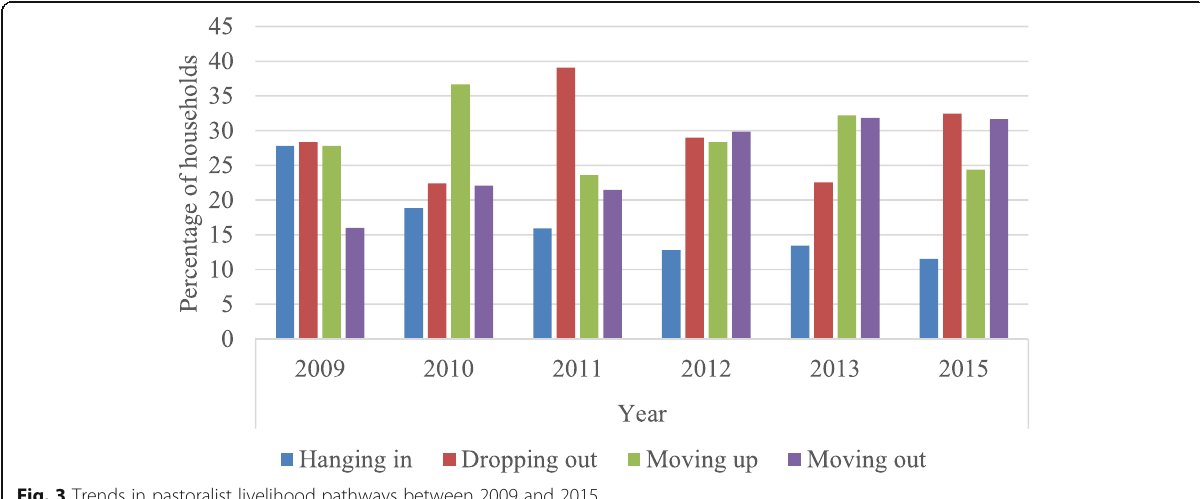
Fig. 3 Trends in pastoralist livelihood pathways between 2009 and 2015